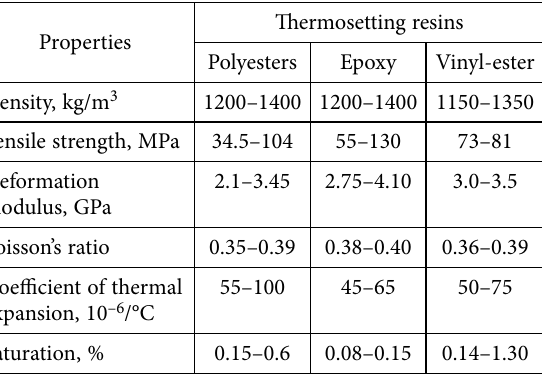
Table 2. Physical and mechanical properties of polyester, epoxy and vinyl-ester resins